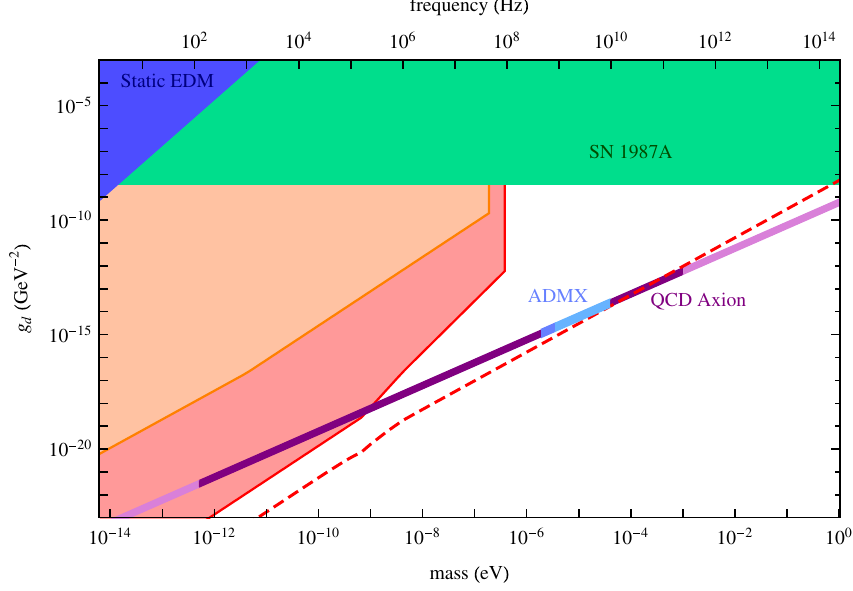
¼ g a and a is the (where the nucleon EDM is d d n d